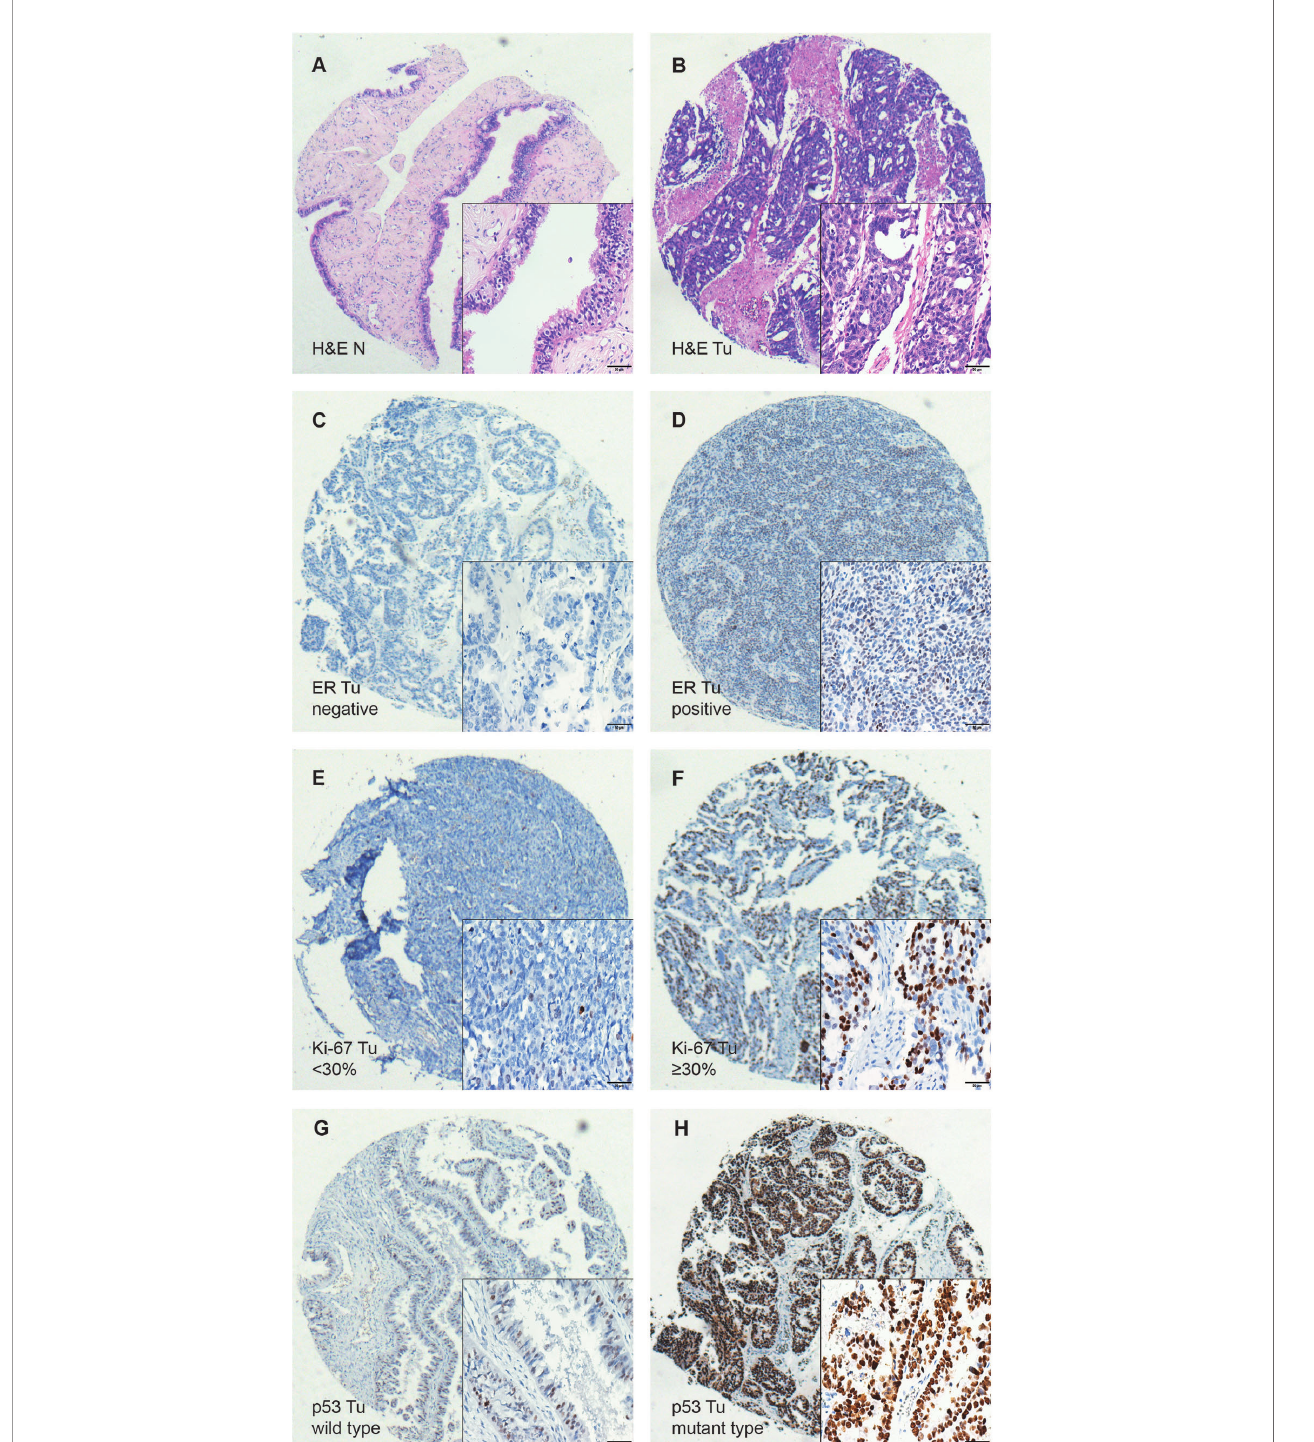
FIGURE 2 | Immunohistochemical staining of H&E, ER, Ki-67, and p53 in HGSOC tissues (Tu) and matched normal fallopian tubes tissue (N), shown at 40× magni fi cation with inset (400×). (A, B) Representative images of H&E in the matched normal epithelium of the fallopian tubes (N) and HGSOC tissues (Tu). (C, D) Representative images of negative and positive ER in HGSOC tissues are presented. (E, F) Representative images of high and low Ki-67 index in HGSOC tissues are shown (G, H) Representative images of mutant type and wild type p53 staining in HGSOC tissues are presented. TILs, tumor-in fi ltrating lymphocytes; HGSOC, high-grade serous ovarian cancer; H&E, Hematoxylin and